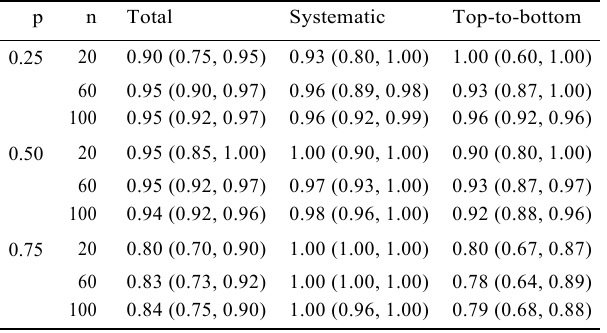
Table 3. Median and interquartile range of the pairwise Pear- Table 1. Median and interquartile range of classification accu- son's correlations of the cluster racy based on the k- means clustering of transition matrices. Systematic Top-to-bottom